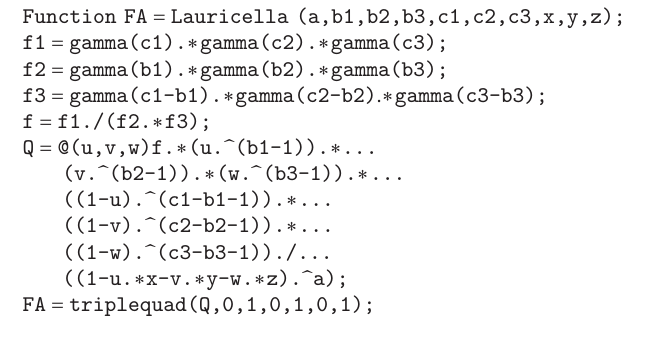
Algorithm 2: MATLAB Program for evaluating 𝐹 (3) 𝐴 (⋅)